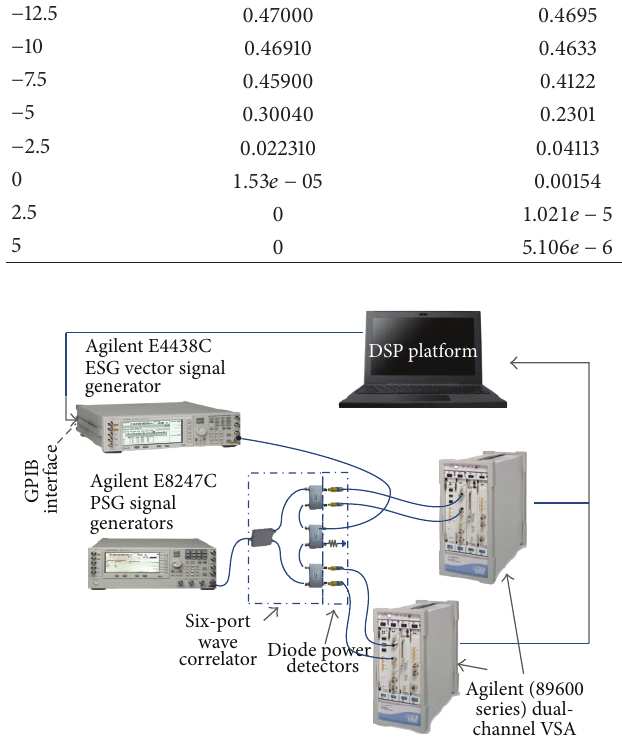
Figure 4: Test bench setup for the SPR